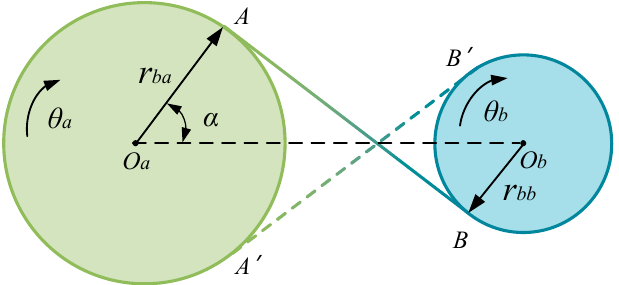
Figure 3. Torsional meshing deformation relationship between the planetary gear a j and the planetary gear b j .